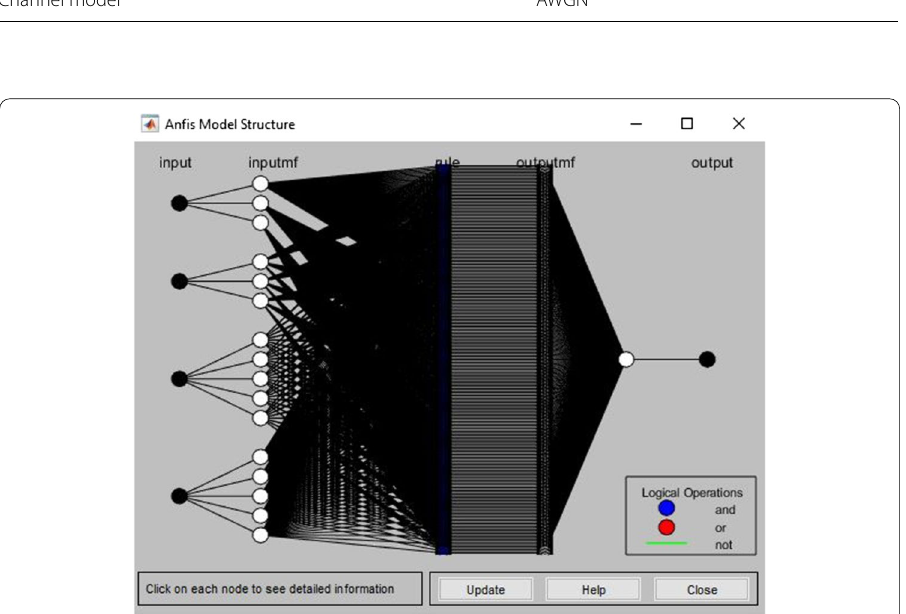
Fig. 4 ANFIS structure with four inputs and one output. A diagram constructed in MATLAB neuro-fuzzy designer apps which depicts ANFIS architecture with four inputs and one